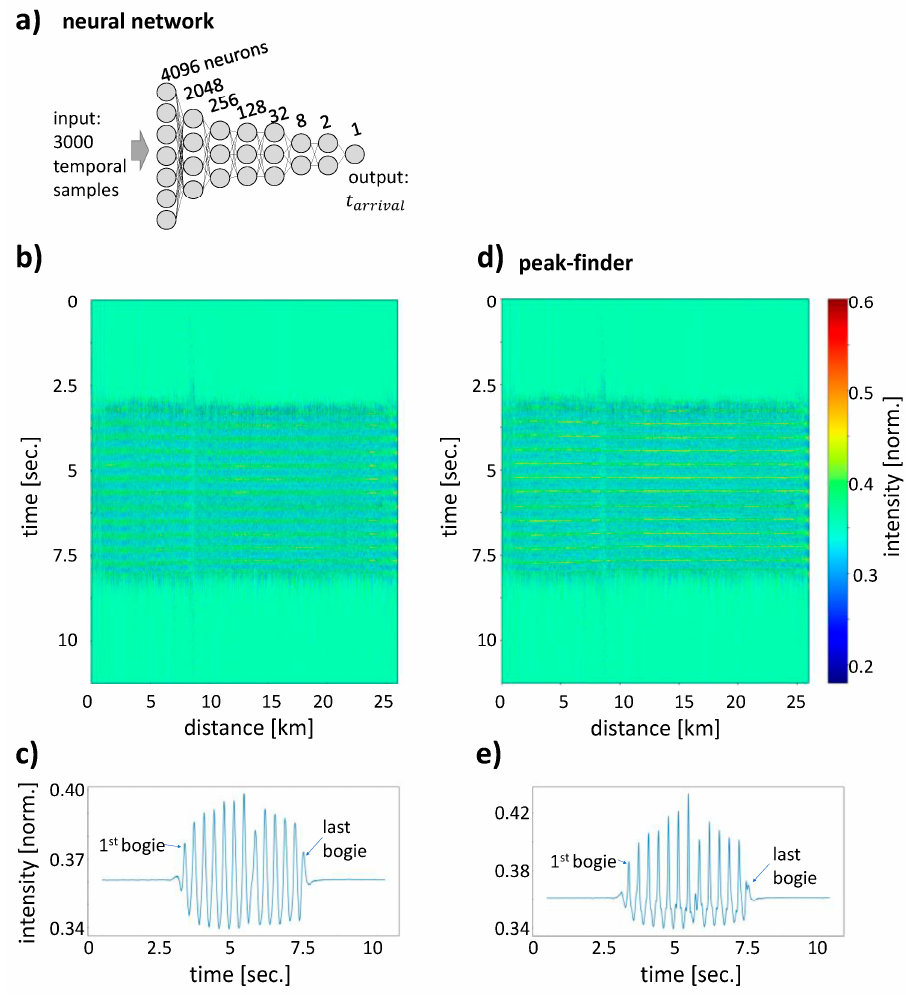
Figure 4. ( a ) Artificial neural networks (ANN) can successfully predict the precise arrival times of a bogie cluster so that a well aligned rail-view graph ( b ) can be generated. ( c ) Taking the spatial average of the rail-view graph, all bogie clusters can clearly be resolved as 13 peaks. A peak finder algorithm performs similarly to the ANN in aligning the bins for a rail-view graph ( d ) and again 13 peaks can be found as well but the peak height is more uneven ( e ).